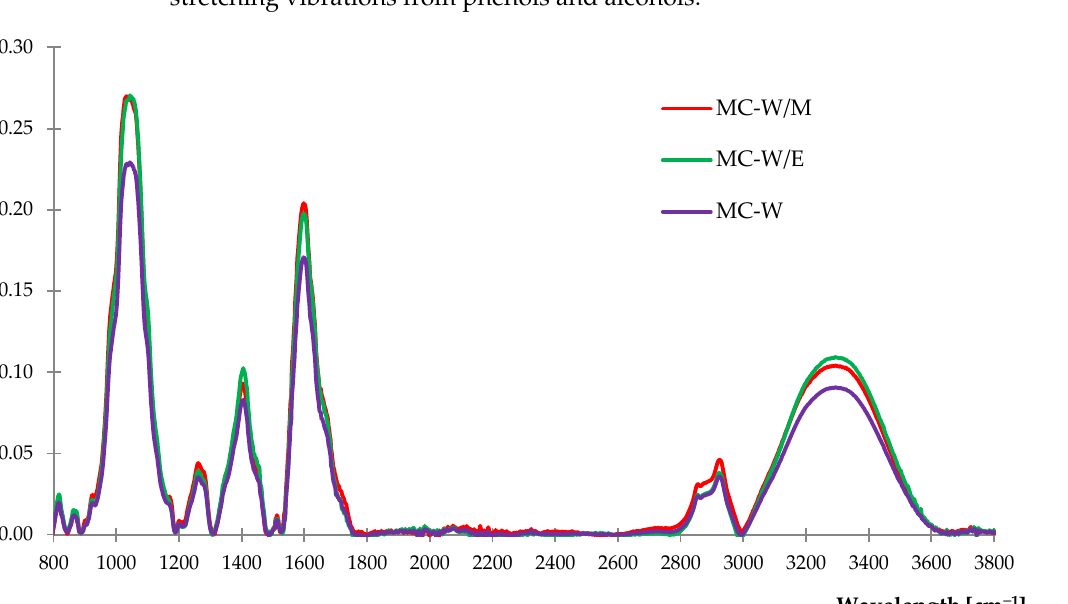
Figure 2. The FTIR spectra of common yarrow freeze-dried extracts.